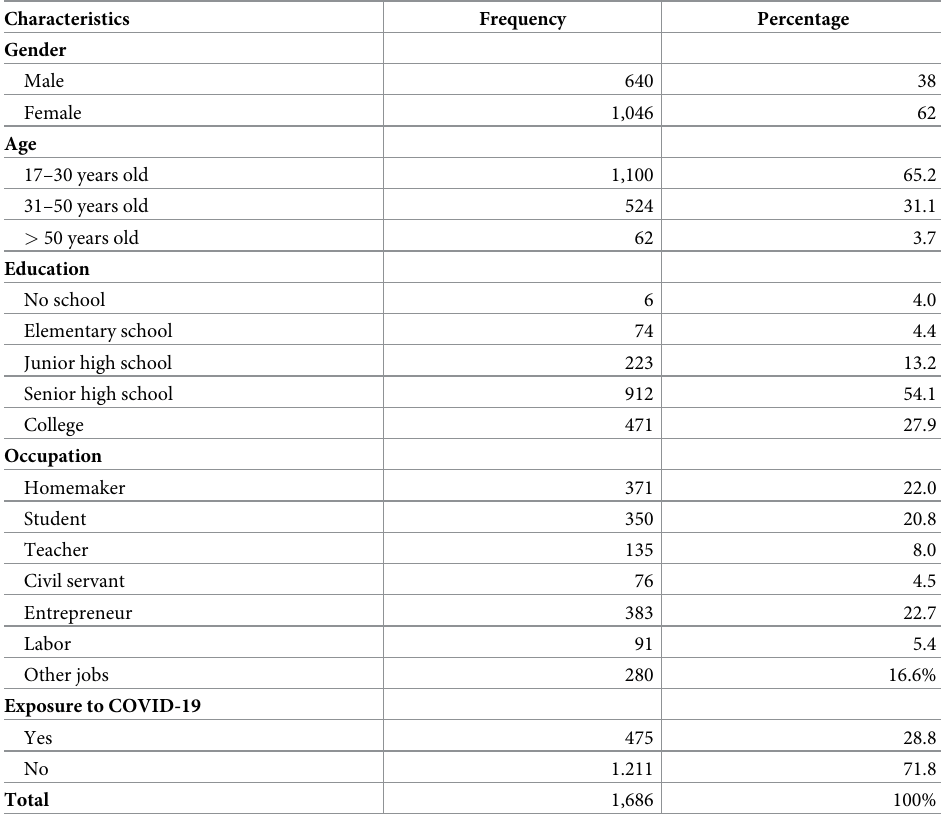
Table 1. Characteristics of COVID-19 stigma respondents (n =